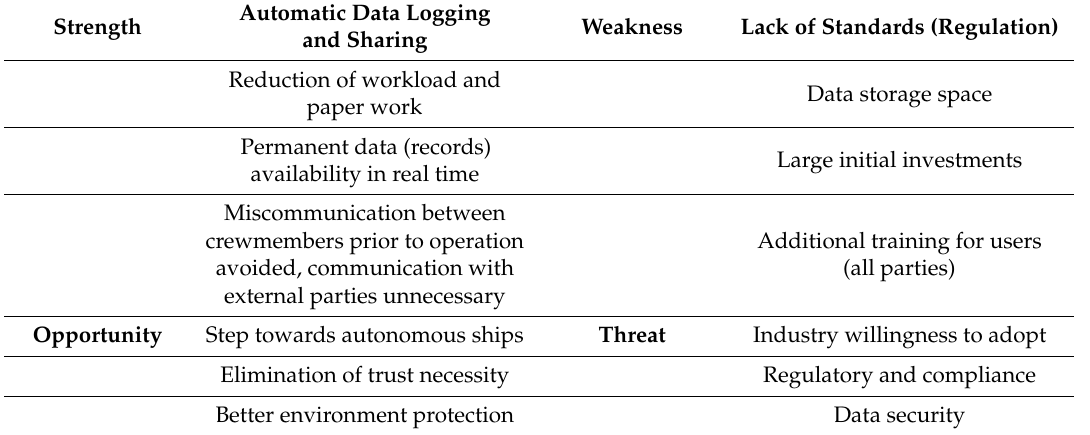
Table 1. SWOT analysis of BCT usage for discharge of grey water overboard from ships. Source: